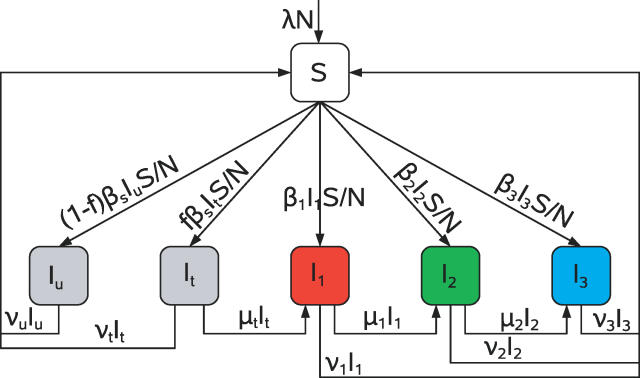
Flow Diagram of the Compartmental Model Describing Gonorrhea Transmission within a Homogenous Core GroupNot shown are the flows out of each compartment at rate λ. Table 1 summarizes the variables and parameters. A detailed explanation of the model is given in the text.